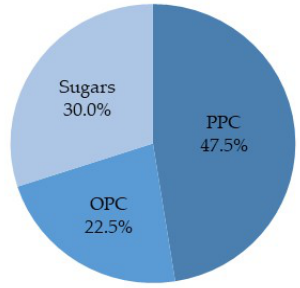
Figure 7. Relative theoretical amounts of the main grape seed components after fractionation by the integrated UF / SPE process.